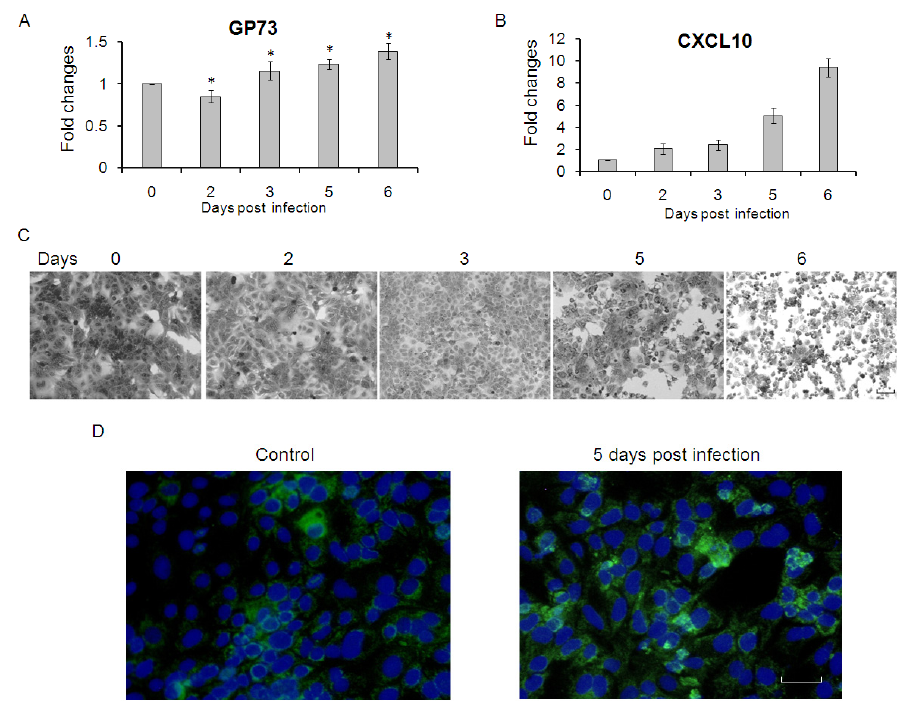
Figure 3. GP73 is up-regulated in Huh7.5.1 cells with cytopathic effect. ( A ) GP73 and CXCL10 ( B ) were measured by real-time RT-PCR in Huh7.5.1 cells at 0, 2, 3, 5 and 6 days after HCV infection ( MOI = 10), (* p < 0.05, compared with control); ( C ) Crystal violet (CV) staining of Huh7.5.1 cells at 0, 2, 3, 5 and 6 days after HCV infection ( MOI = 10). (Scale bar = 50 μ M); and ( D ) Detection of GP73 protein by immunofluorescence assay. (Green for GP73; Blue for nuclei, Scale bar = 50 μ